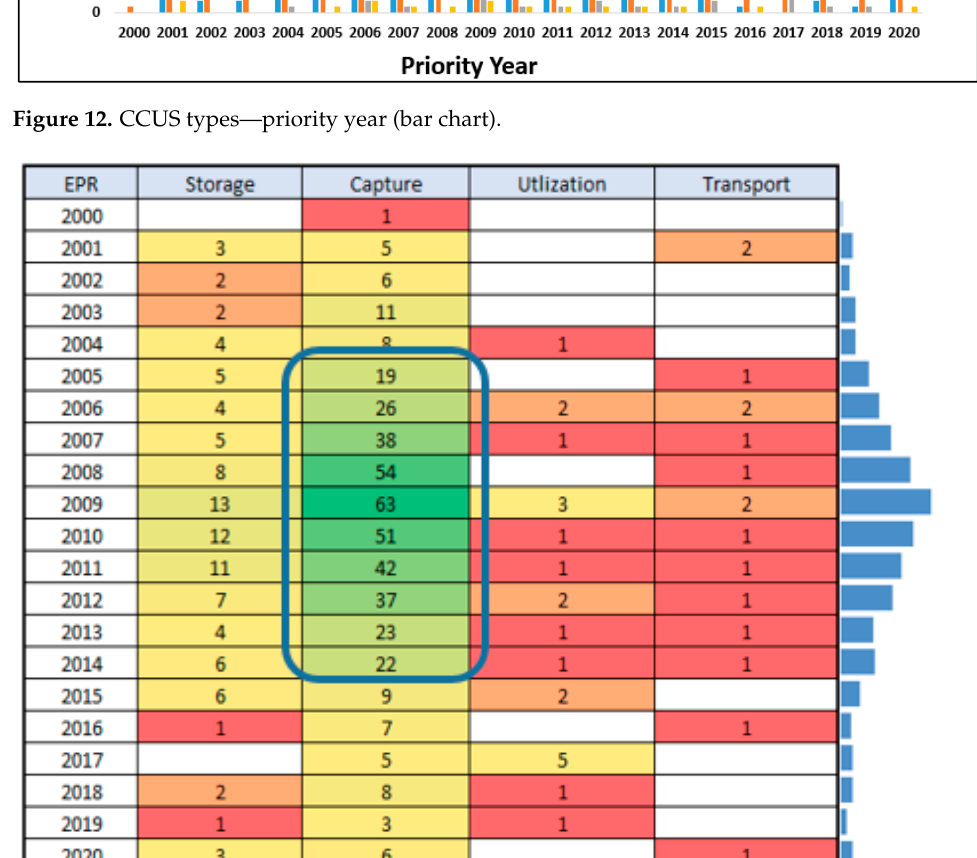
Figure 13. CCUS types—priority year analysis. The figure uses two colors to represent high and low numbers i.e., the more green represents a higher number and more red indicates a lower figure. Blue box represents the highest numbers of CCUS types (capture).